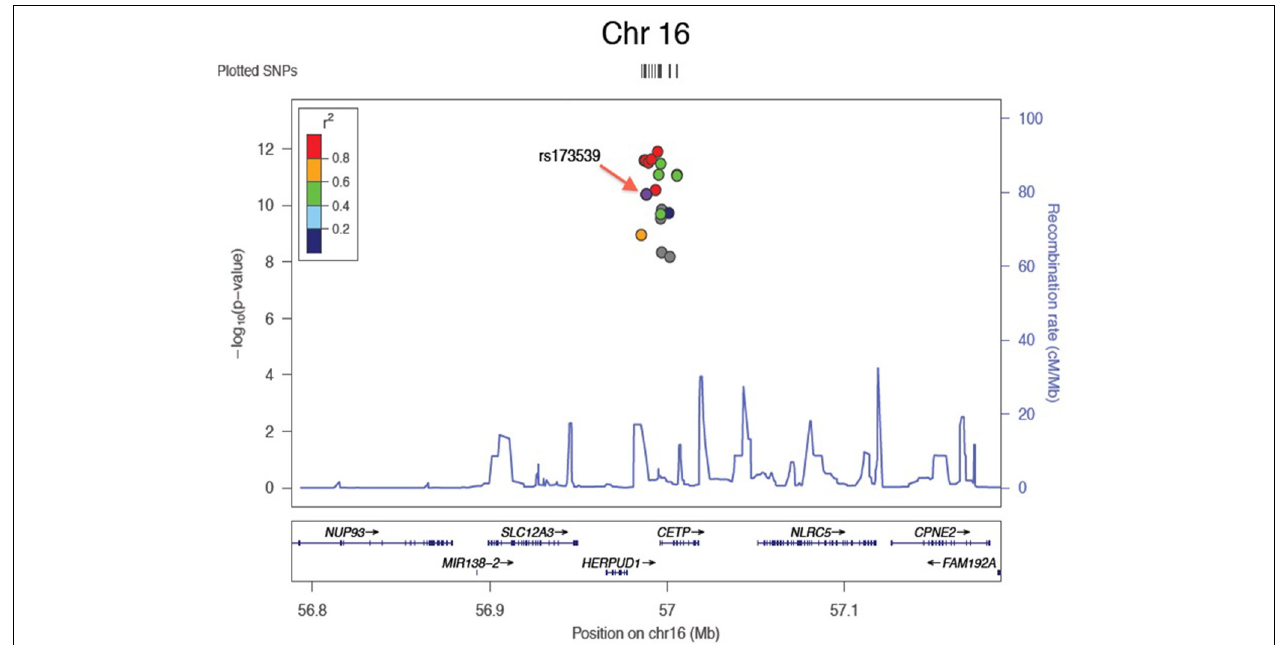
FIGURE 2 | Zoom plot showing association of SNPs in CETP region (Chromosome 16) associated with HDL-C, and linkage disequilibrium between associated SNPs and index SNP.